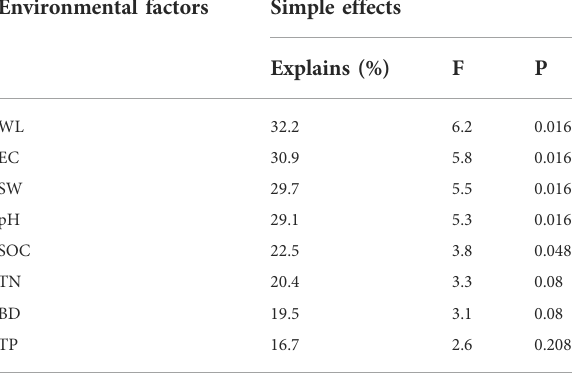
TABLE 3 Interpretation rates of environmental factors for species distribution. Environmental